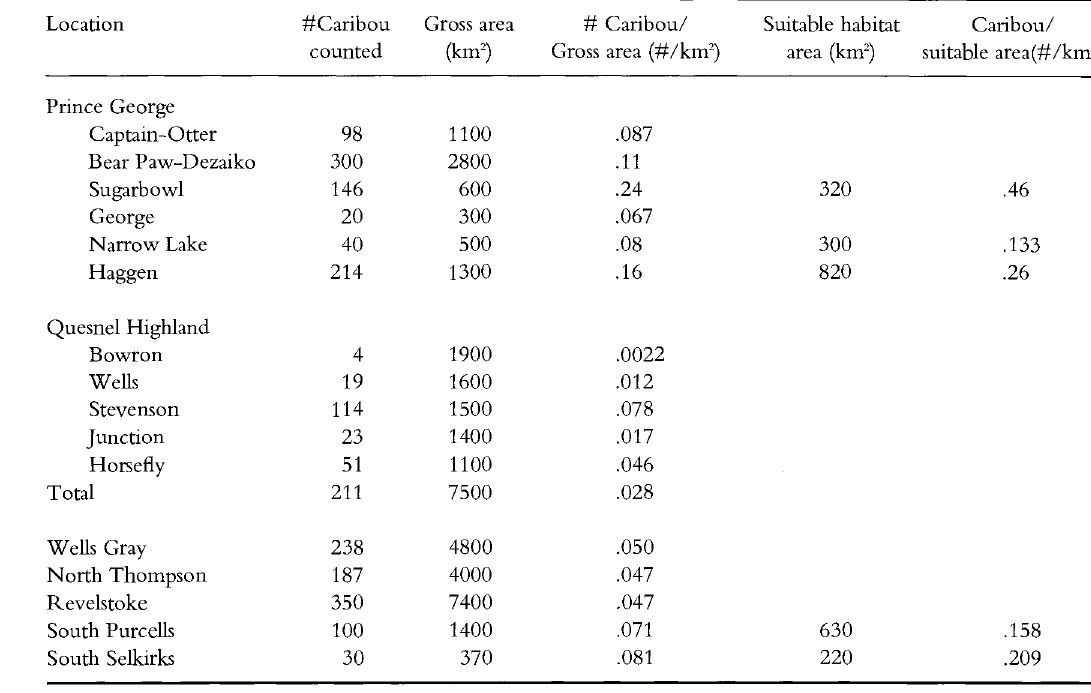
Table 2. Caribou density based on gross area within range and suitable habitat within range.